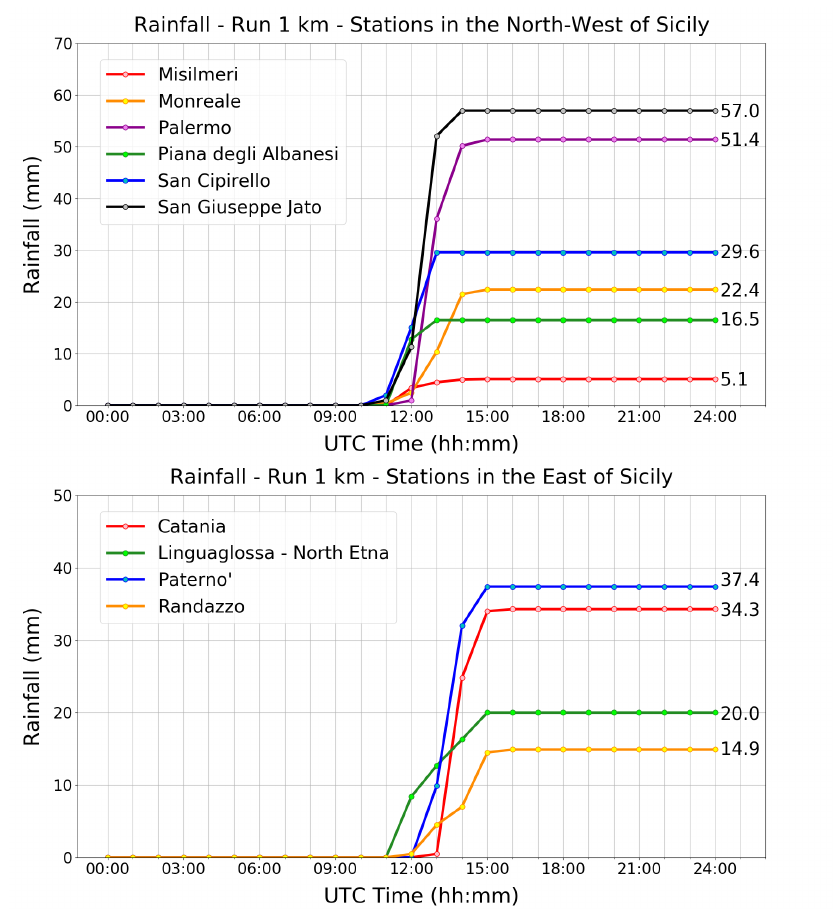
Figure 26. Cumulative rainfall predicted by the WRF model for the whole day of 15 July 2020, with a domain of 1 km and in correspondence of six stations placed in the western part of Sicily ( top ) and of four weather stations placed in the eastern part of Sicily ( bottom ). Table 2. Comparison among cumulative rainfall values (in mm) at the end of the event observed by the DRPC weather stations and those predicted by the WRF model with spatial domains of 3 km and 1